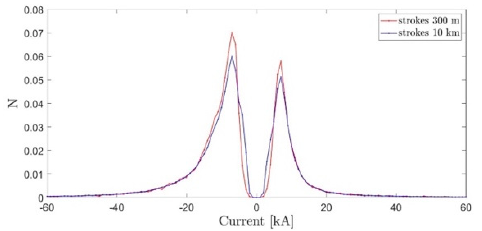
Figure 4. The LINET lightning amplitude distribution over the Mt. Cimone area. Area: 300 m vs 10 km around the observatory. Ref. period: 2012–2020.